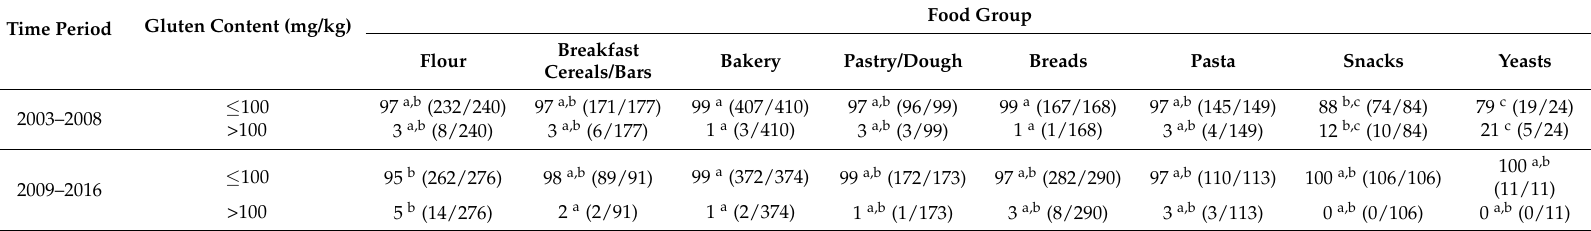
Table 3. Comparison by food groups of samples under or over 100 mg of gluten per kg of product before and after 2008